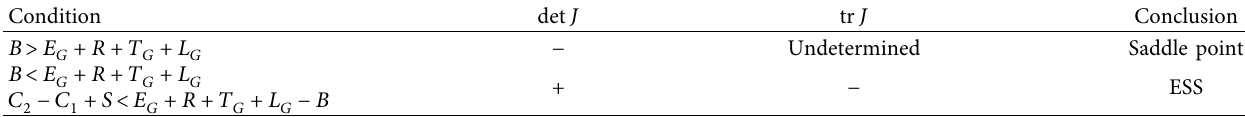
Table 7: Stability discussion of point H (1, 0, 1).